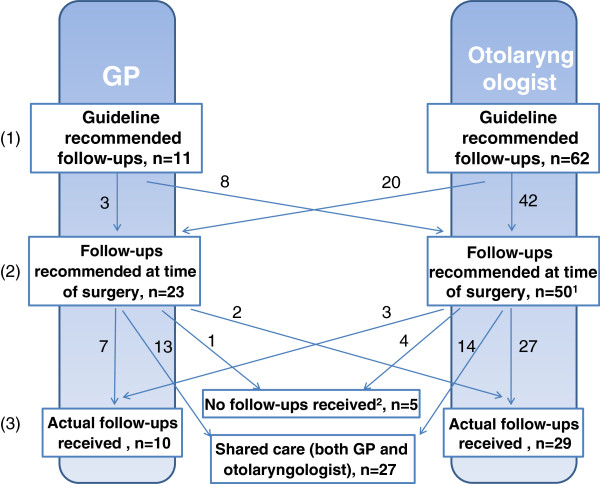
Localization of follow-ups for the participants (n = 73) according to: (1) the guidelines, (2) the recommendations at time of surgery, and (3) the actual control. 1Missing data from two participants 2Reasons for no follow-ups are explored in a previous paper [33].